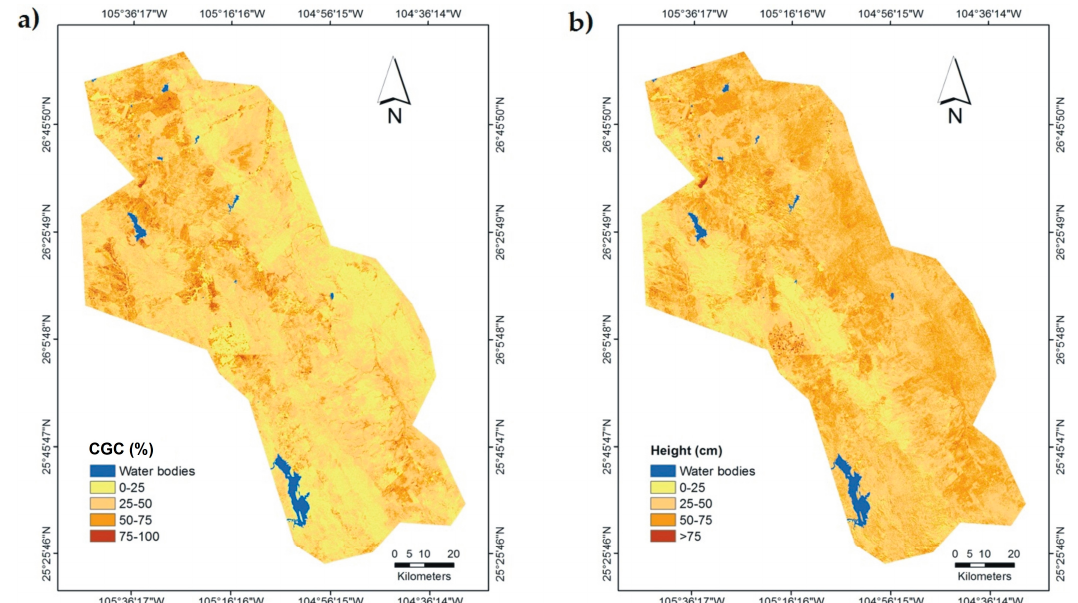
Figure 6. ( a ) Coverage of grass canopy (CGC) and ( b ) grass height distributions for 2011.